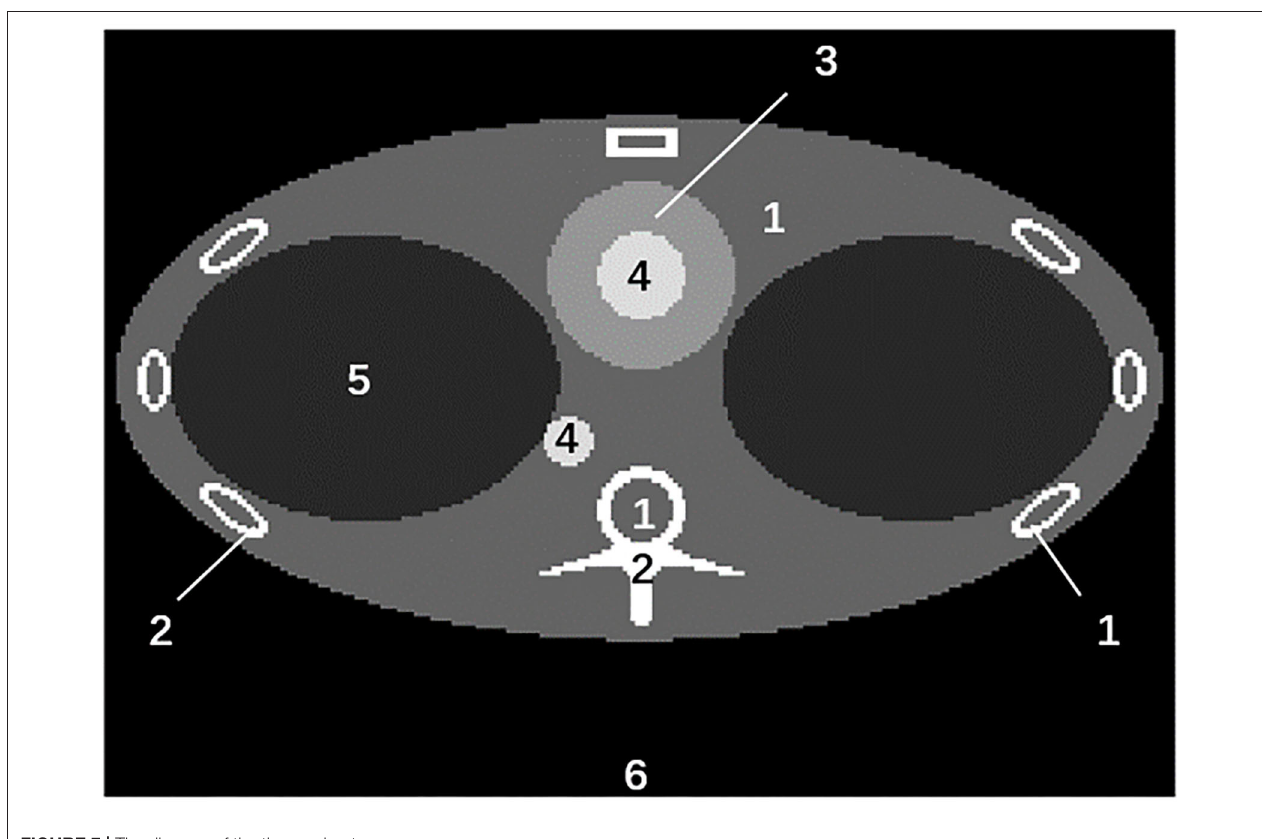
FIGURE 7 | The diagram of the thorax phantom.